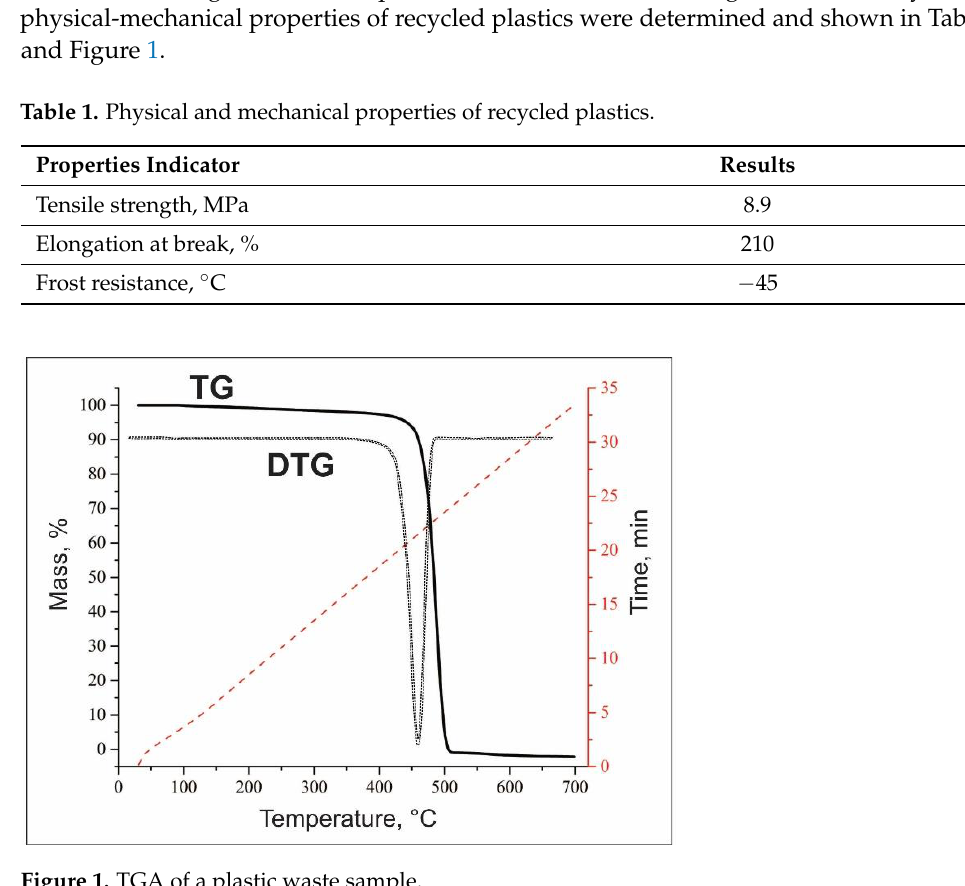
Table 1. Physical and mechanical properties of recycled plastics.